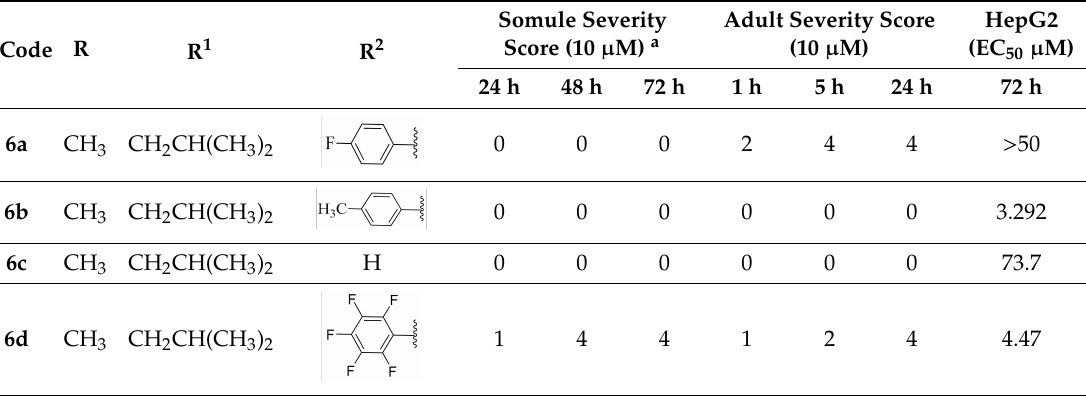
Table 1. Bioactivity and counter toxicity data for Pht analogues 6 ( a – u’